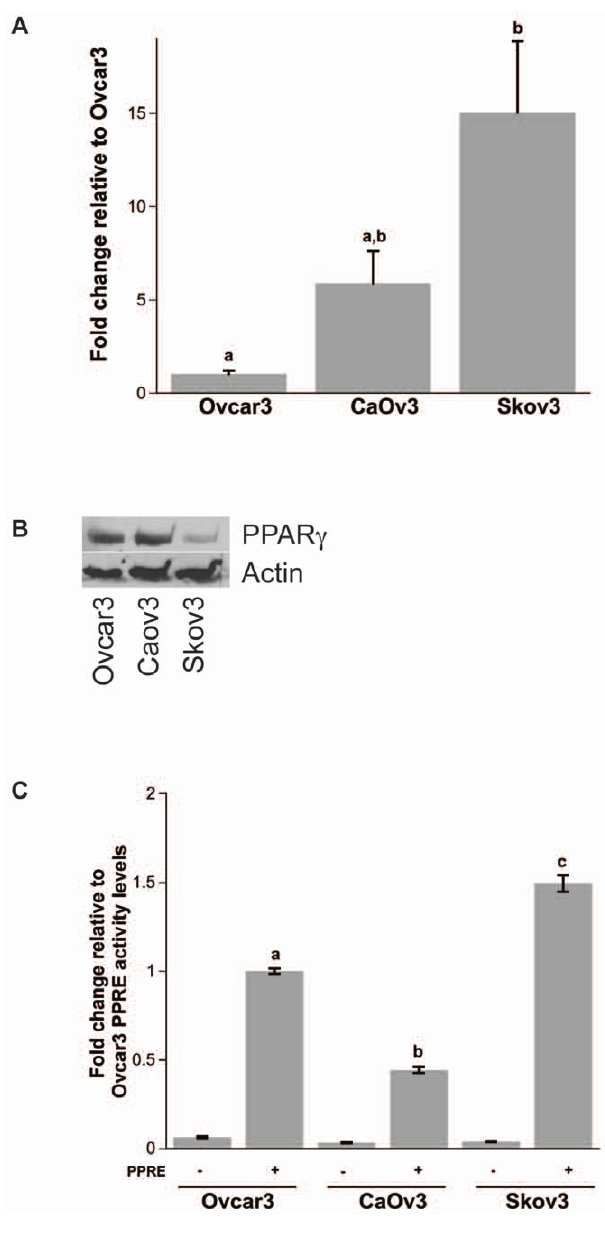
Figure 1. Expression of PPAR c in three ovarian cancer cell lines (Ovcar3, CaOv3, Skov3). ( A ) mRNA expression ( B ) Protein expression and ( C ) PPRE luciferase activity. Data was normalized to levels of PPAR c expression and activity in Ovcar3 cells. Results are the means 6 SEM for at least 3 measurements from three individual experiments. Bars that do not share a letter designation are significantly different ( p , 0.05). Cells transfected with Luc and Renilla constructs lacking PPRE (PPRE 2 ) were significantly lower than the same cell line transfected with PPRE- Luciferase-Renilla constructs (PPRE + ) by Welch’s t-test ( p , 0.05).